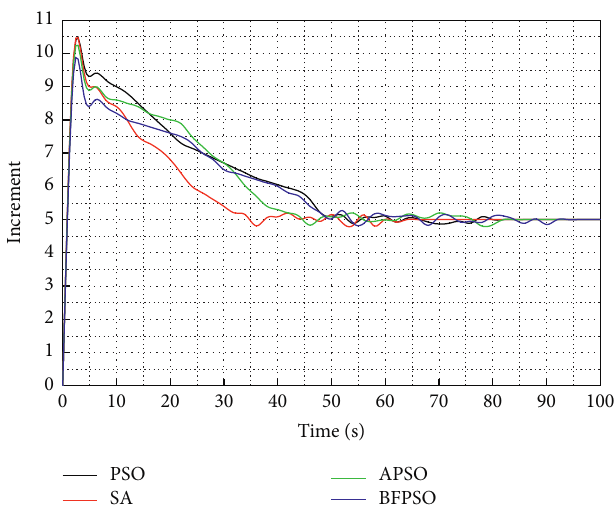
Figure 5: Incremental response of pitch angle of the system designed by 4